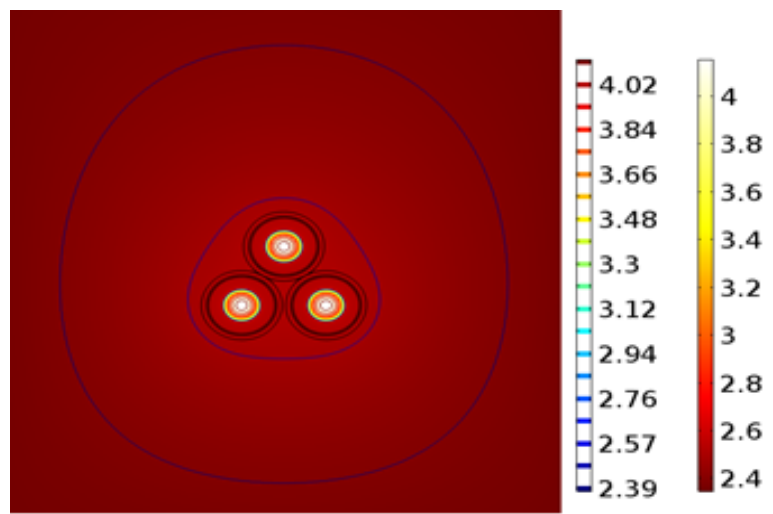
Figure 7. Temperature distribution on the cable surface for the maximum negative temperature difference in a triangular system on a logarithmic scale (log10 (T)).